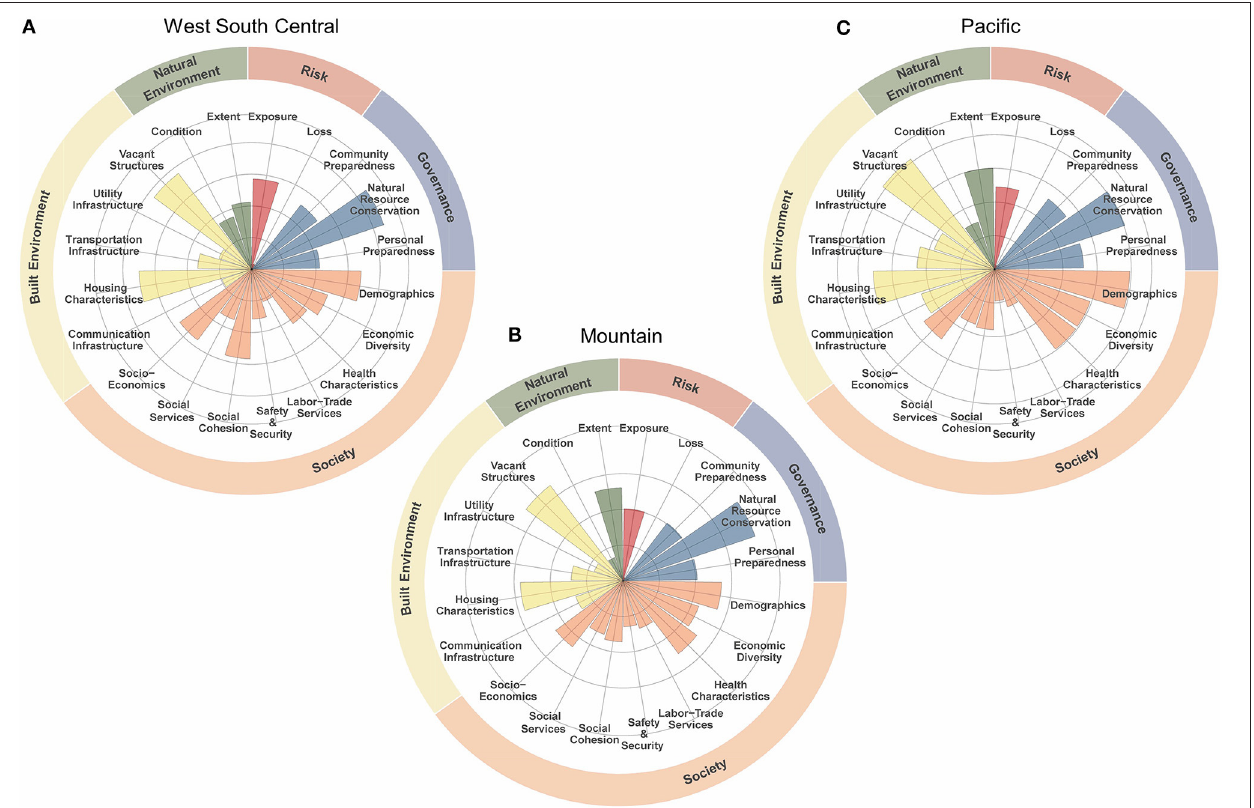
FIGURE 7 | Polar plots of the (A) West South Central, (B) Mountain, and (C) Pacific